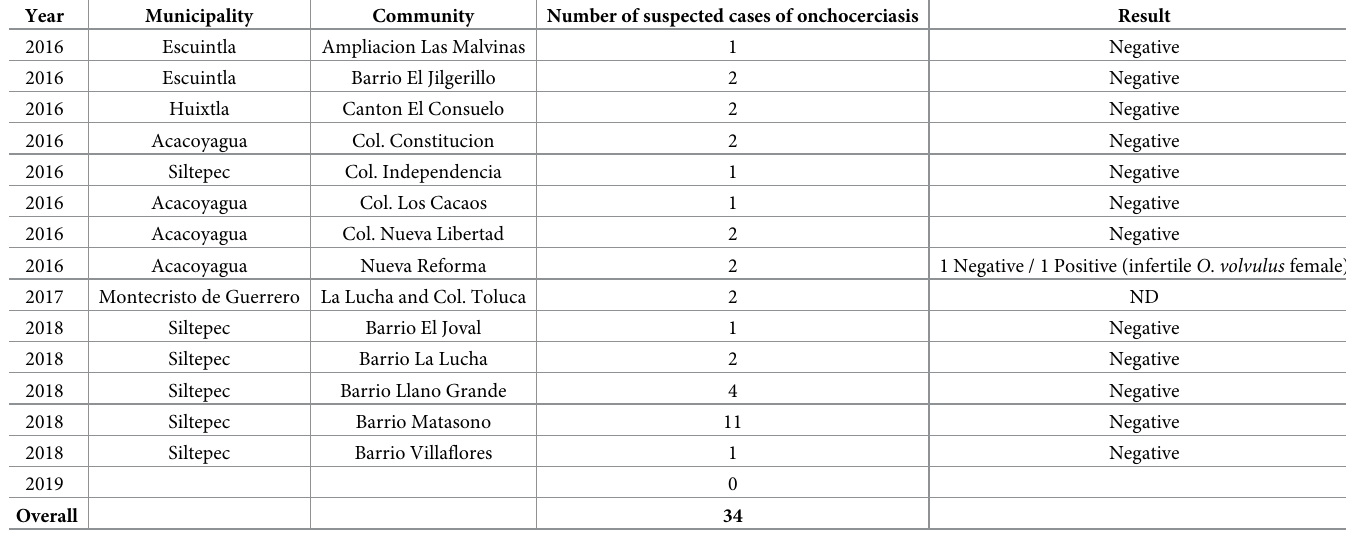
Table 2. Number of suspected cases of onchocerciasis in the formerly endemic focus of Southern Chiapas, Mexico from